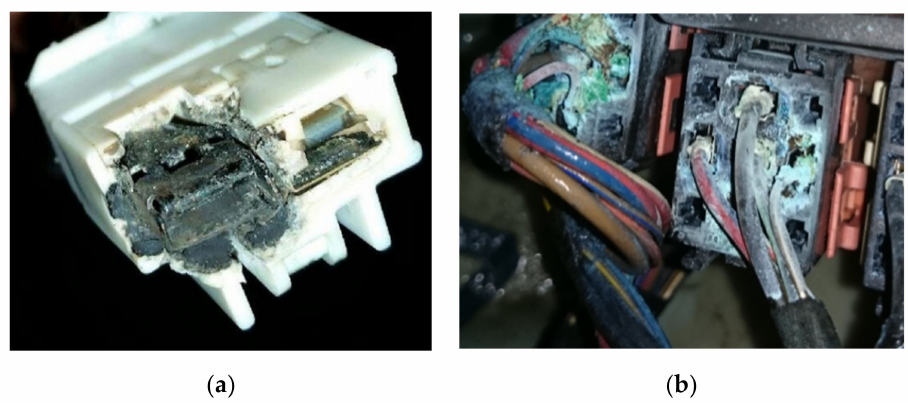
Figure 1. Examples of corroded connectors: ( a ) corroded Ac blower wire harness connector in an Acura TL [20]; ( b ) corroded wiper control relays in a BMW 7 series [21].